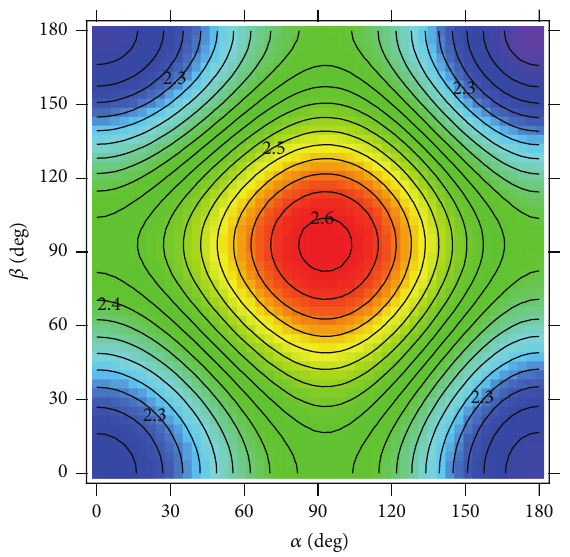
Figure 4: Contour plot of HOMO-LUMO gap of the BCNDTS molecule as a function of the two angles 𝛼 and 𝛽